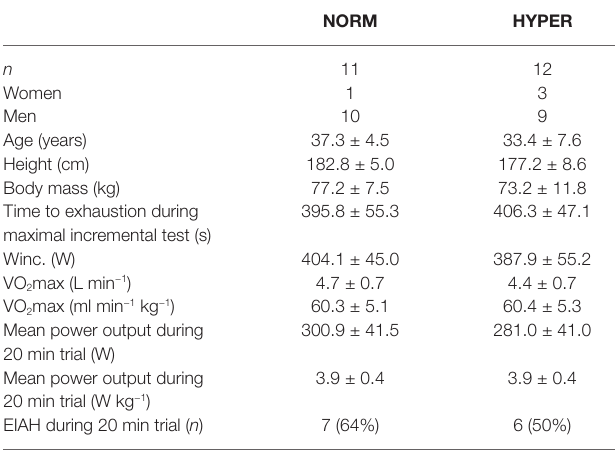
Data are mean ± SD. Winc., maximum watt pedaled during the maximal incremental test; EIAH, exercise induced arterial hypoxemia (defined as SaO 2 lower than 95%).